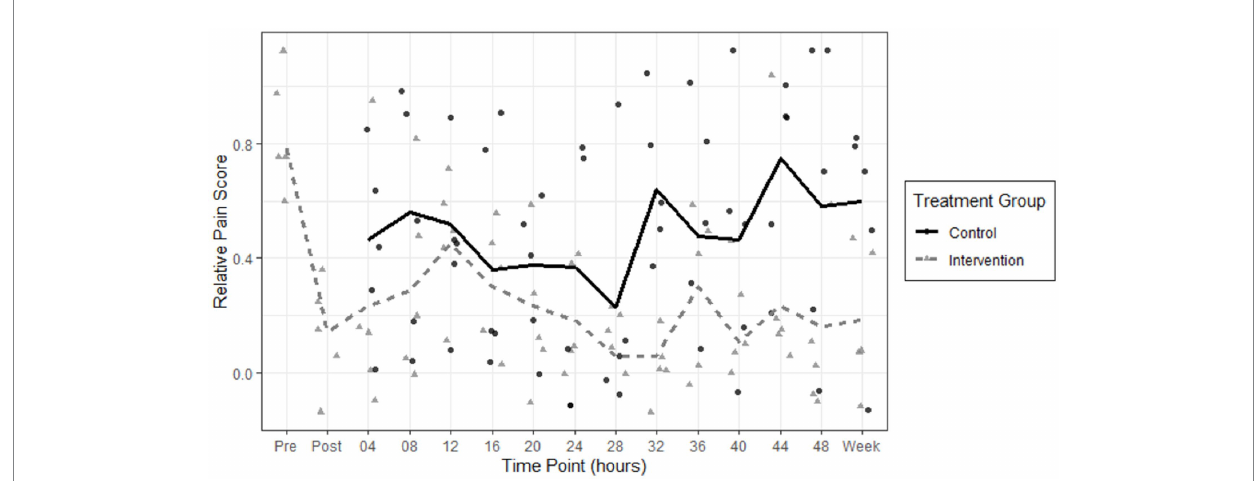
FIGURE 3 Scatterplot of relative NPRS pain scores in the control group (circles) and intervention peripheral nerve block (triangles) groups are shown over 48 h and on one-week follow up. A solid line shows the mean pain scores of the control group, and a dashed line shows the mean pain scores of the intervention group. The pain scores in the intervention group decrease immediately after the peripheral nerve blocks and remain lower over time, compared to the control